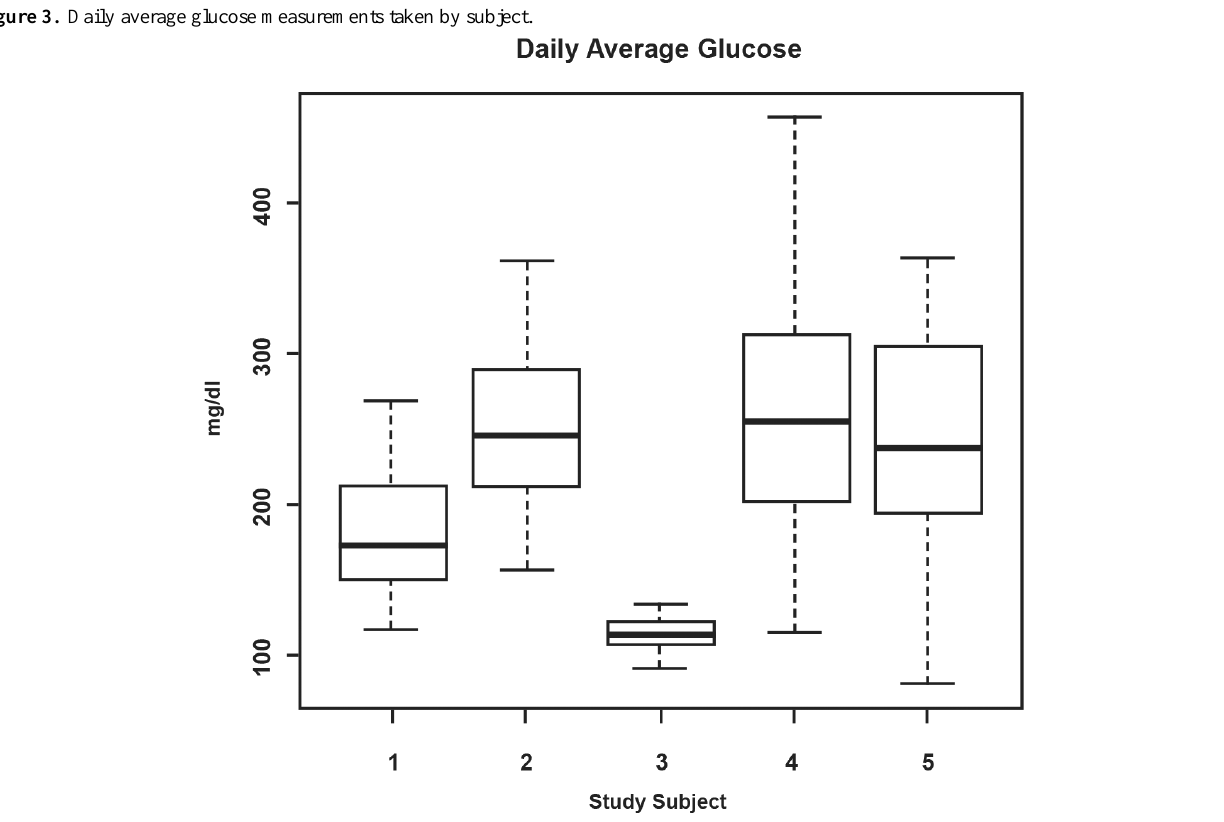
Figure 3. Daily average glucose measurements taken by